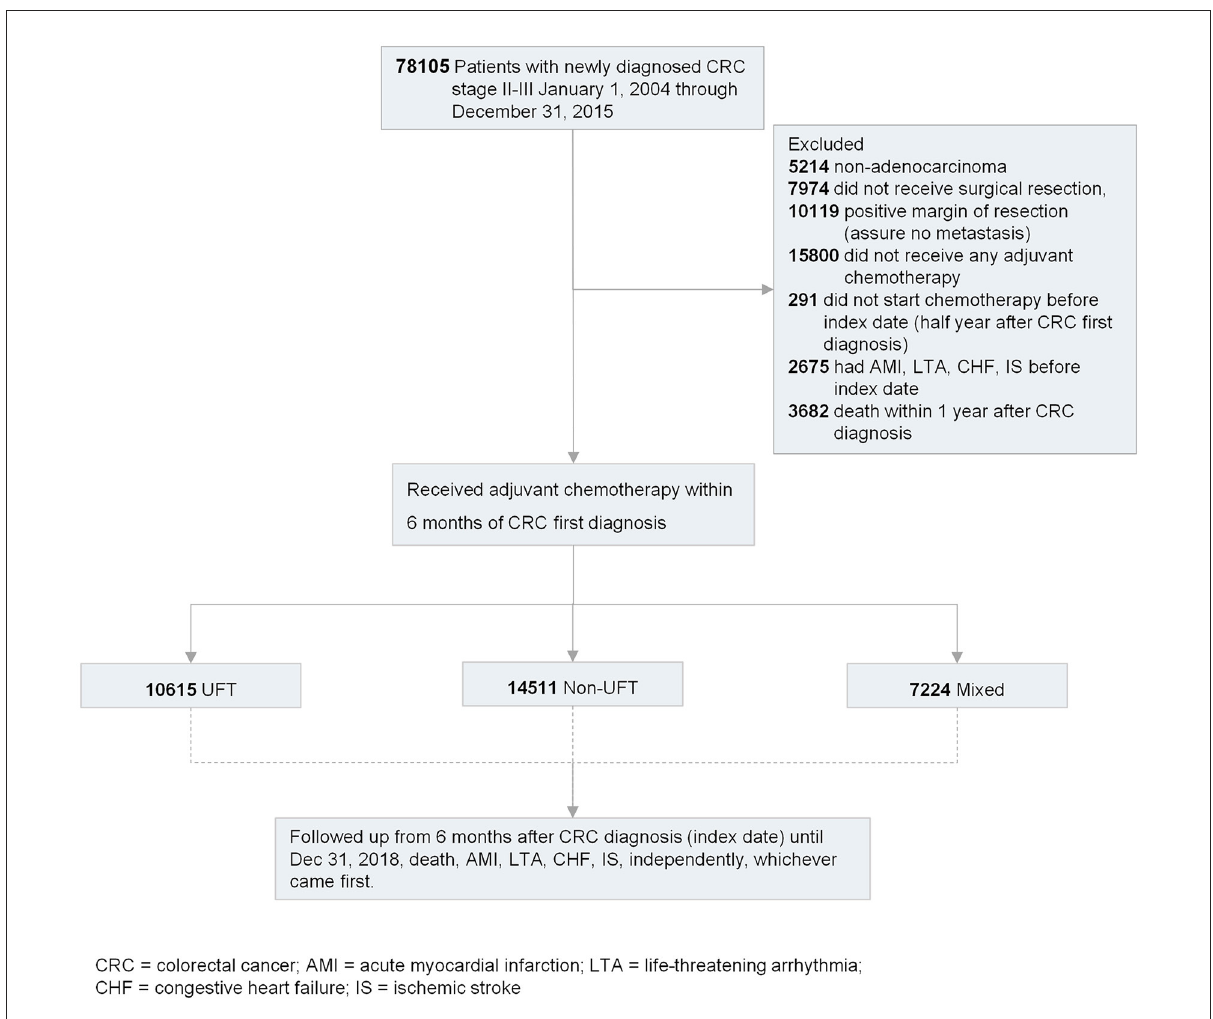
FIGURE2 Flowchart of enrolling study participants and follow-up for study